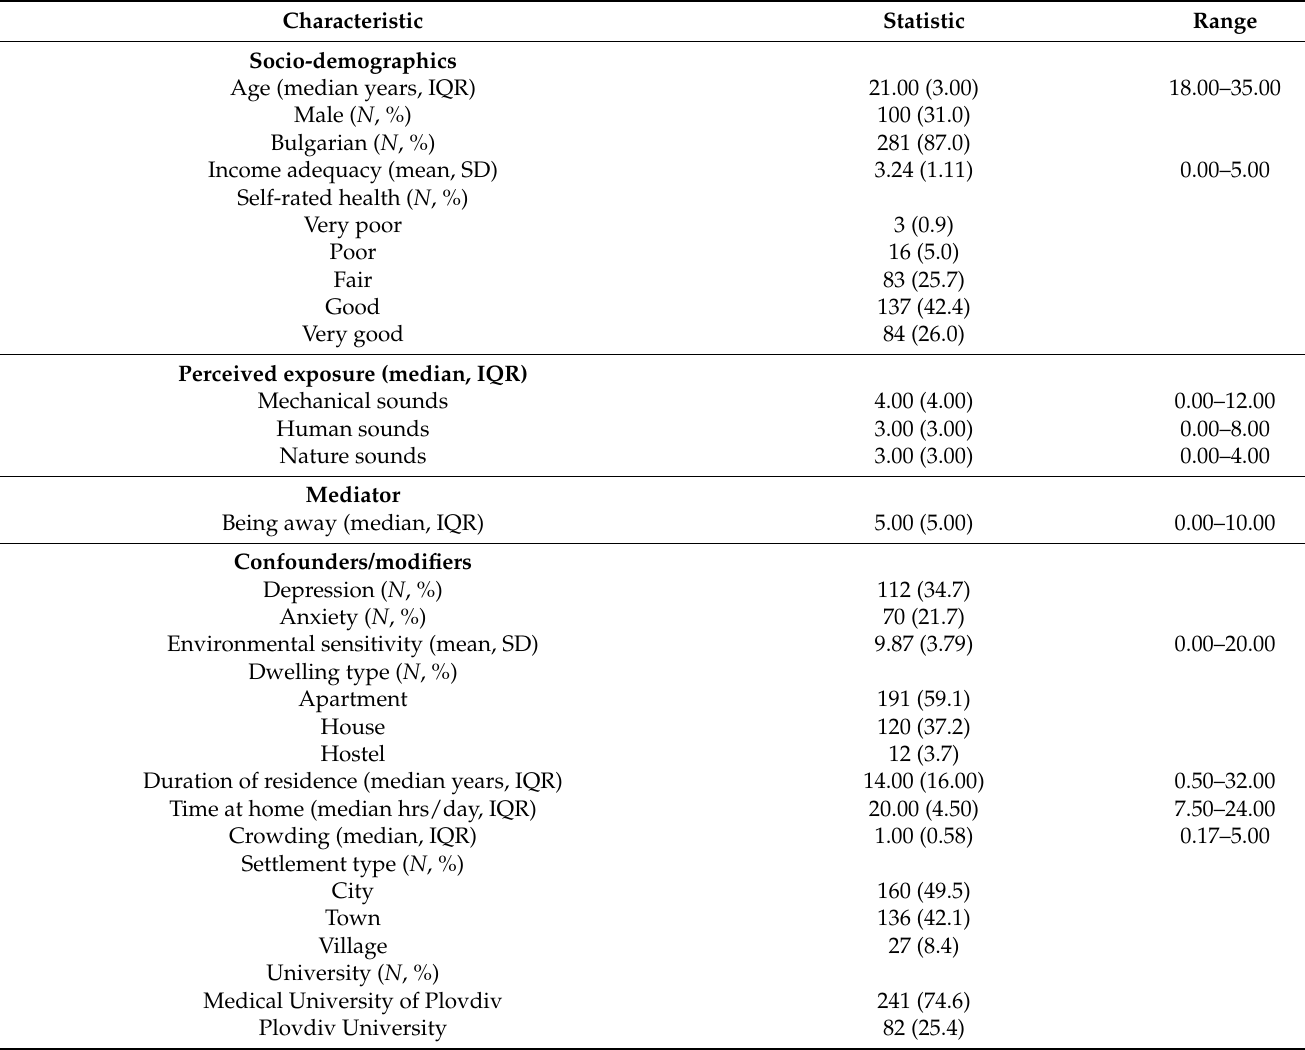
Abbreviations: IQR—interquartile range, SD—standard